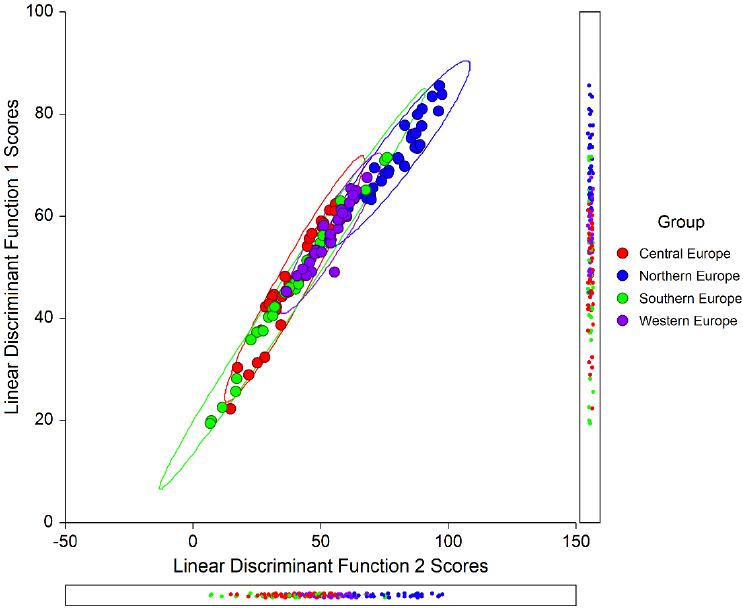
Figure 5. Linear discriminant functions – regional score analysis (source: authors’